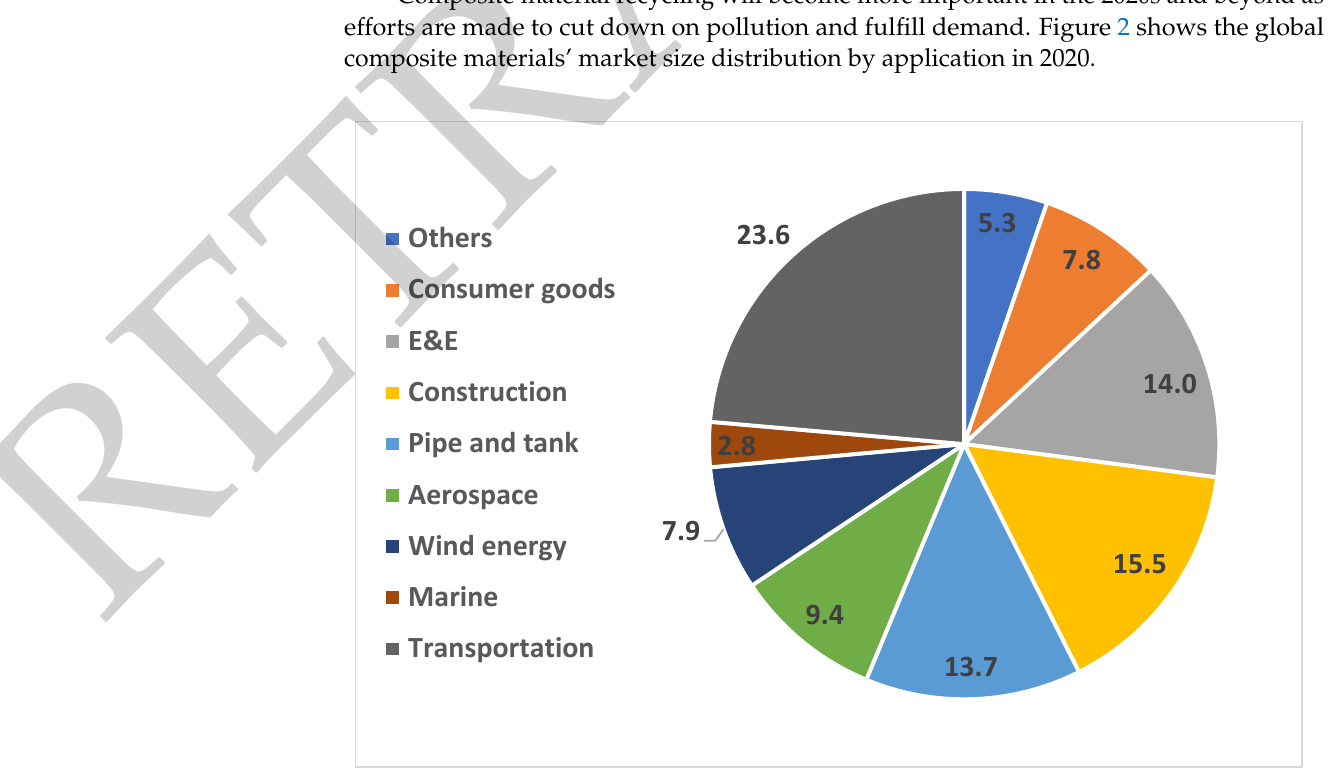
Figure 2. Global composite materials’ market size distribution, by application, in 2020 [2].